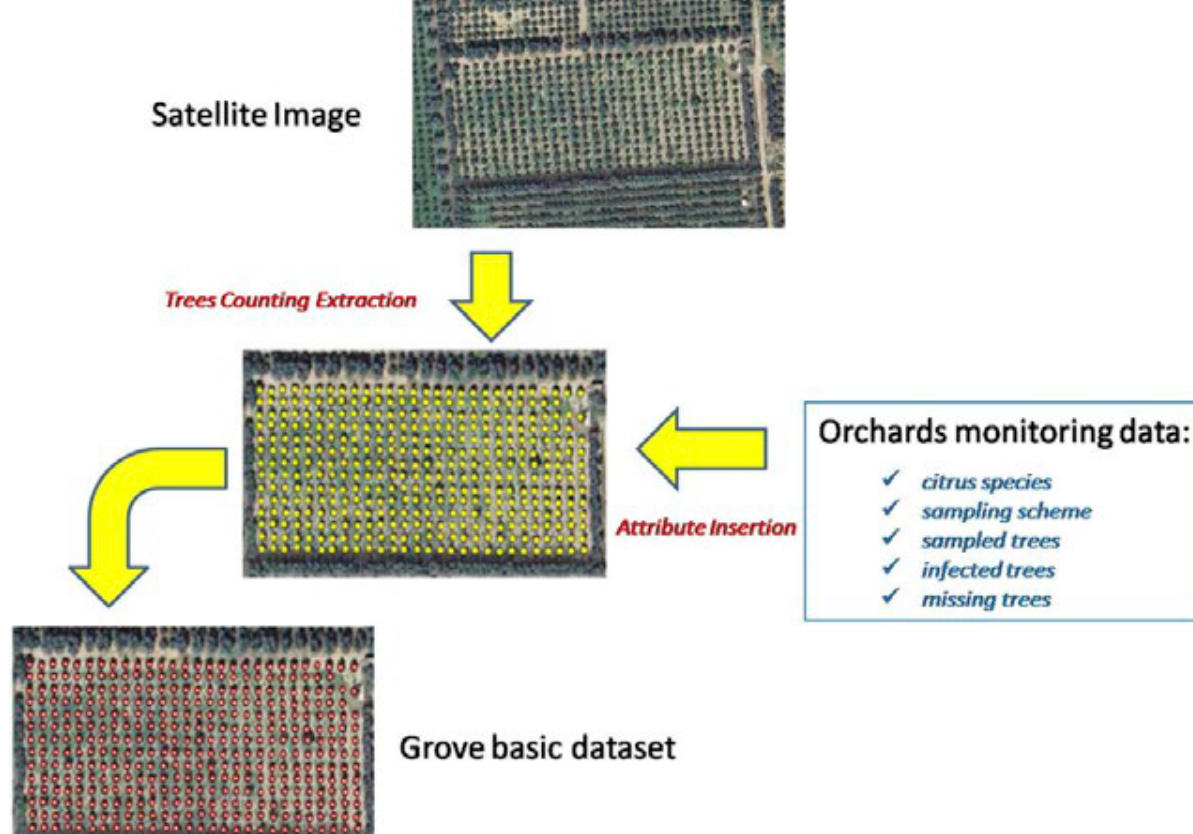
Figure 3. Scheme of data processing from the satellite image WorldView-2 of the study area to the grove basic